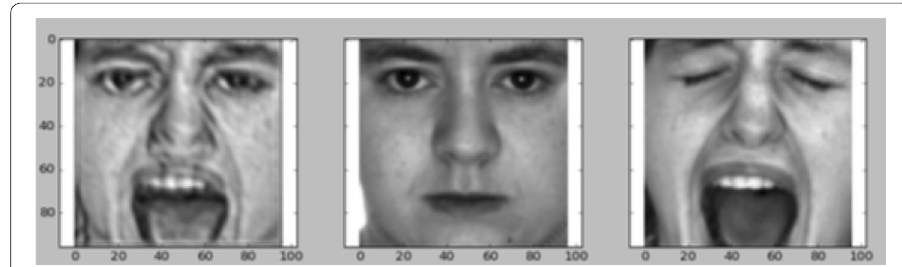
Fig. 31 On the gender recognition task, the image to the left is an example of an instance produced by Network-A in Smart Augmentation given the right images as input